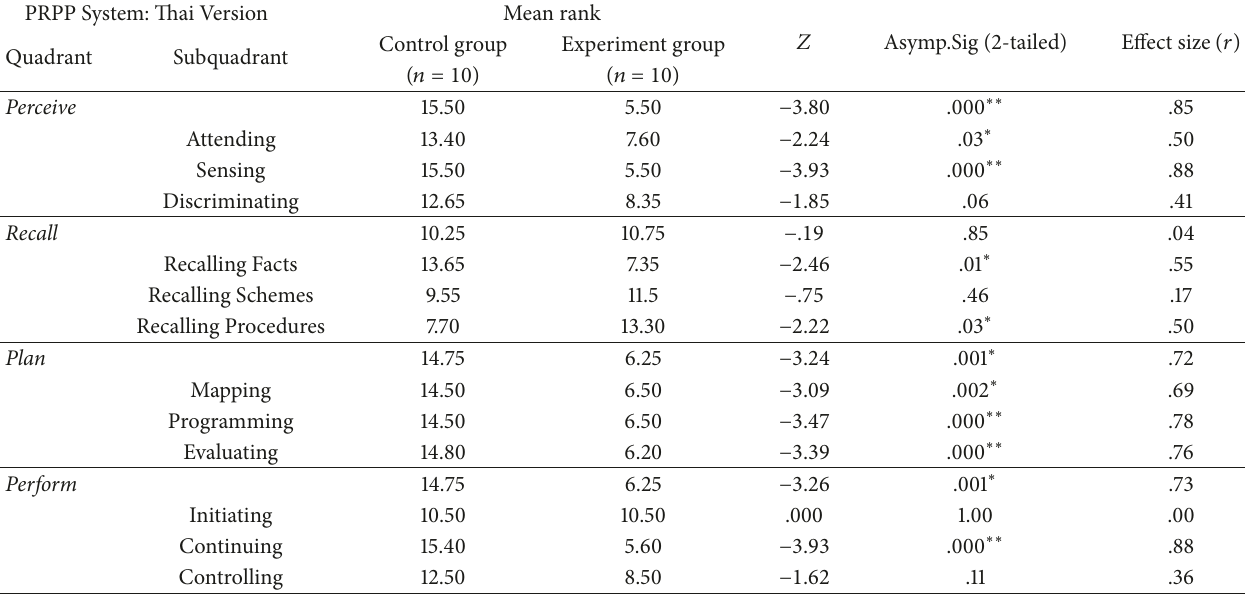
Table 7: The comparison of quadrant and subquadrant posttest scores between the control and experimental group on the academic activity (reading comprehension and written